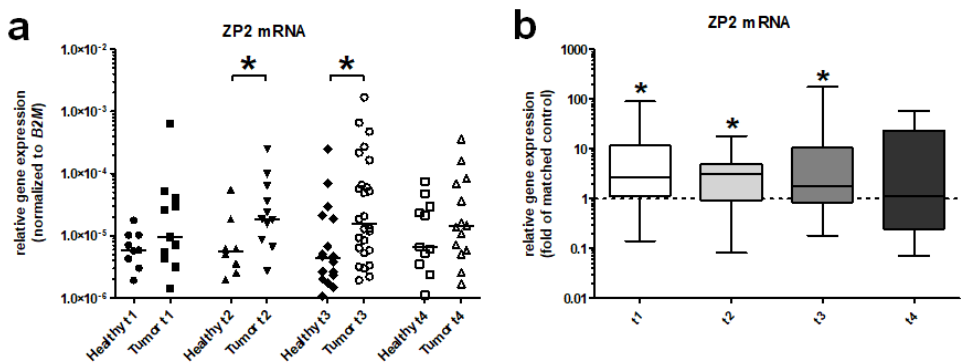
Figure 4. Differential relative gene expression analysis of ZP2 in different tumor stages. ( a ) Comparison of ZP2 expression levels between different tumor stages (T1–T4) with their healthy matched control tissue samples. ZP2 exhibits a significantly increased expression in T2 and T3 stage tumor specimens vs. controls. ( b ) Differential relative gene expression analysis of ZP2 focusing on different tumor stages, which shows significantly increased levels of transcription in T1, T2, and T3 compared to their matched healthy controls. Significant differences are marked with asterisks (* for p < 0.05).